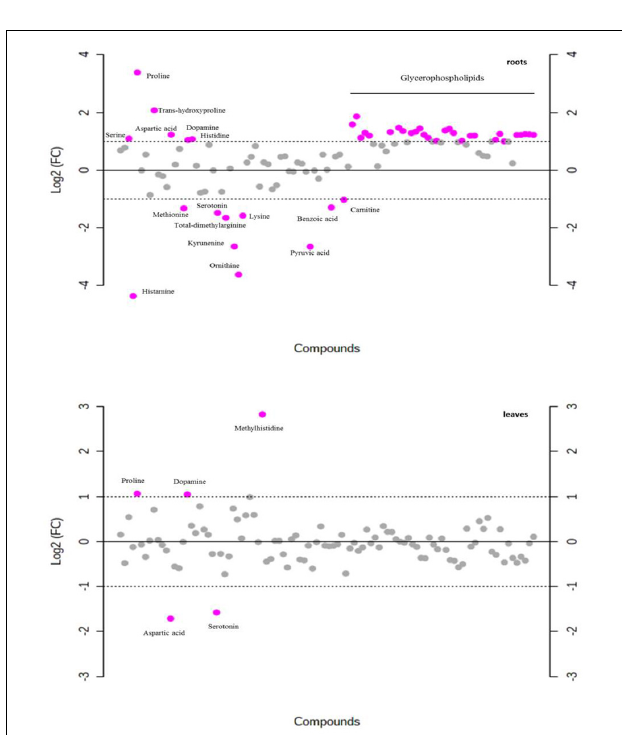
FIGURE 8 | Fold-change analysis with threshold 2 of each metabolite in roots and leaves of P. nuttalliana treated with 150 mM NaCl for 6 days compared with the plants treated with 0 mM NaCl. The values are on log scale, so that both up-regulated and down-regulated features are plotted in a symmetrical way. Gray circles represent metabolites with no significant